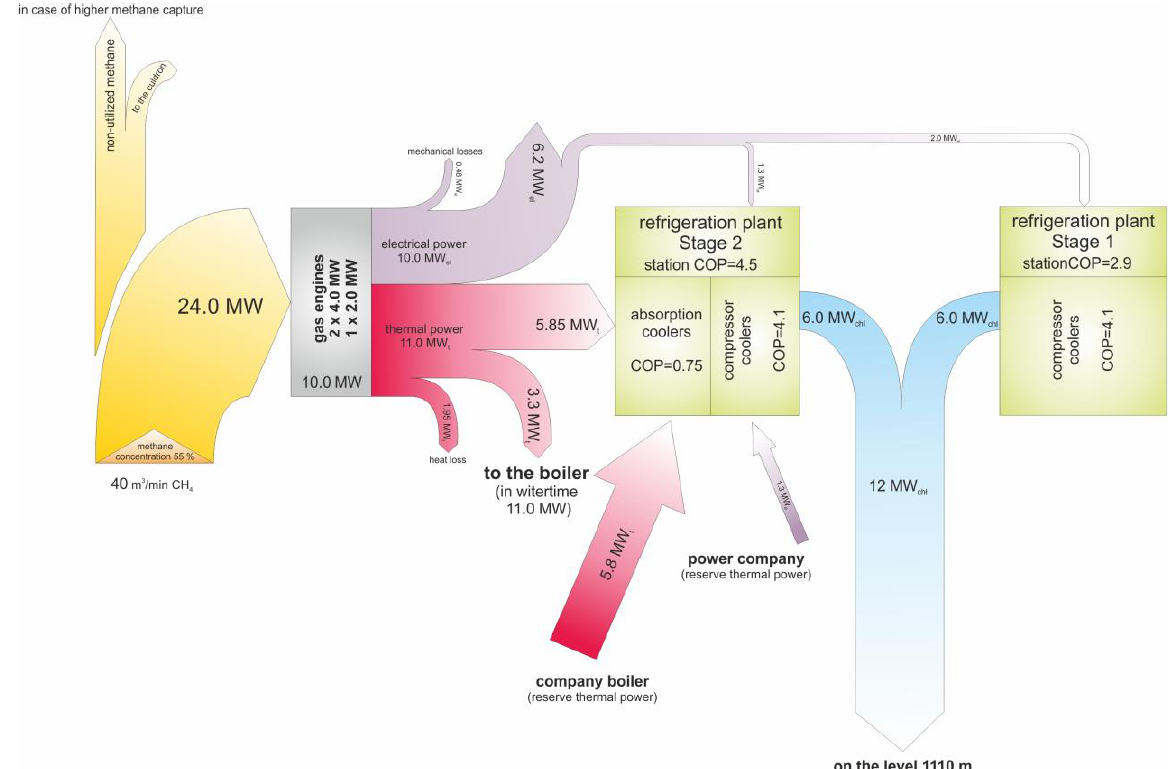
Figure 10. Heat balance of the methane and heat flow.